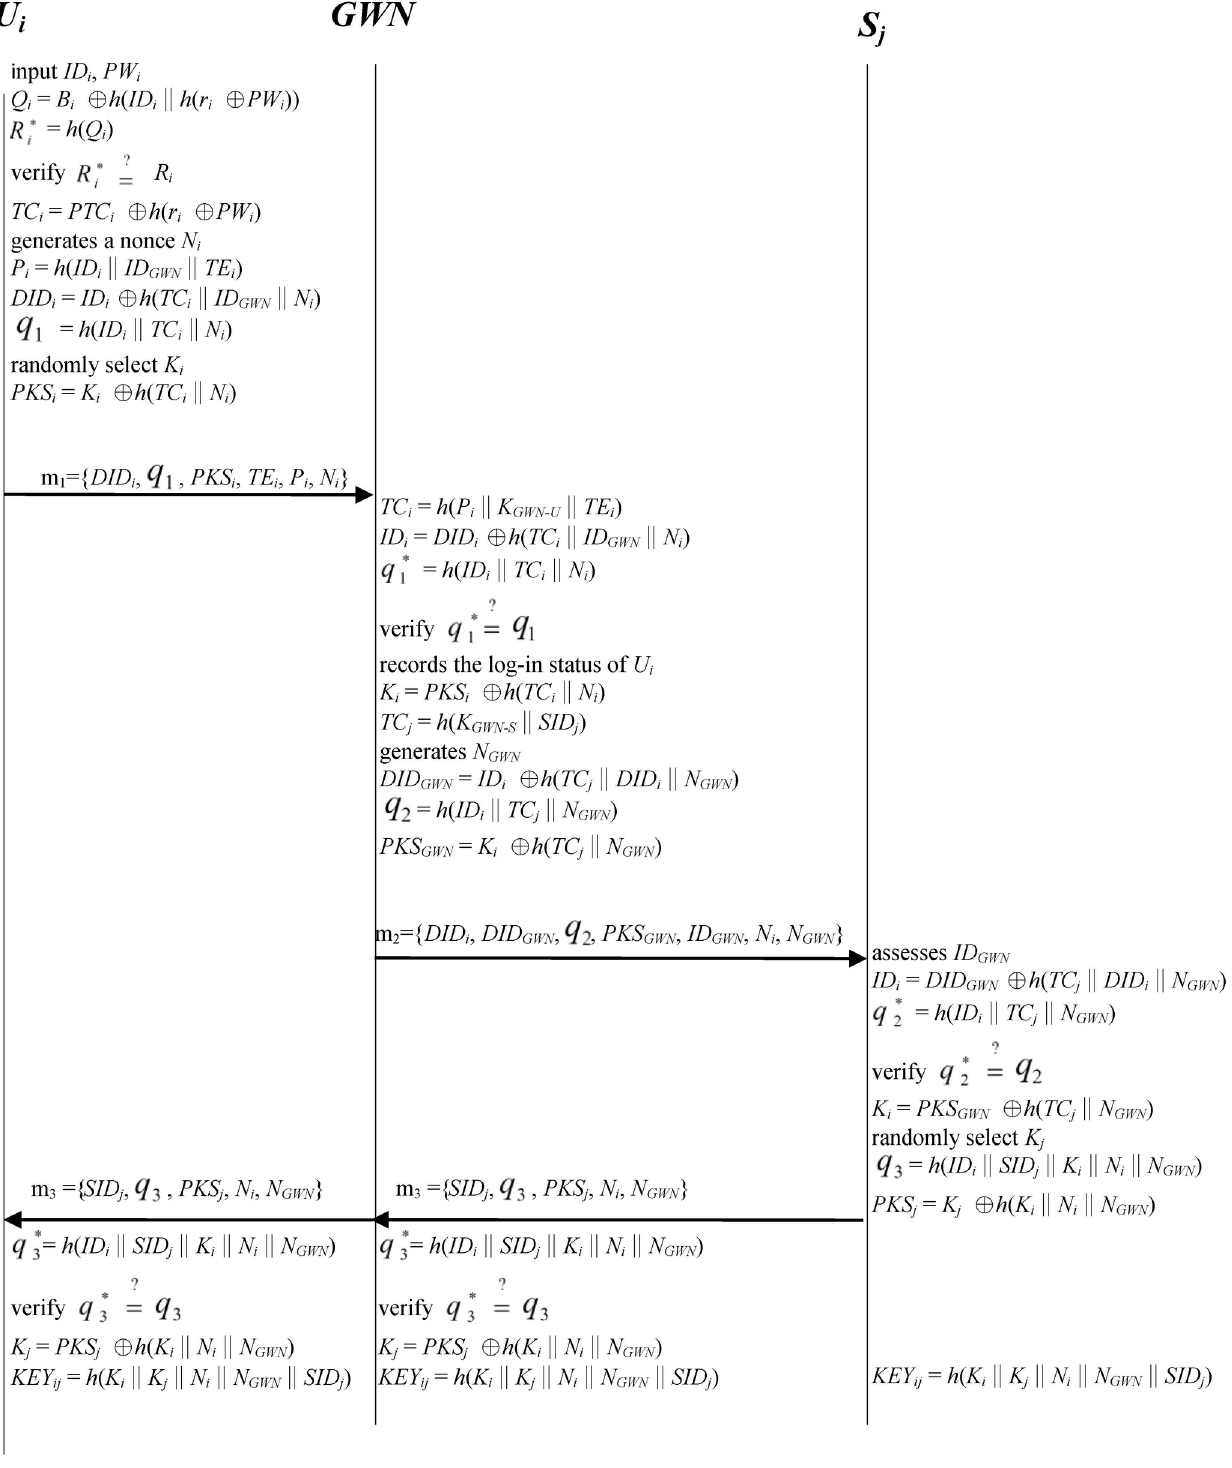
Fig 4. Login phase; authentication and key agreement phase.